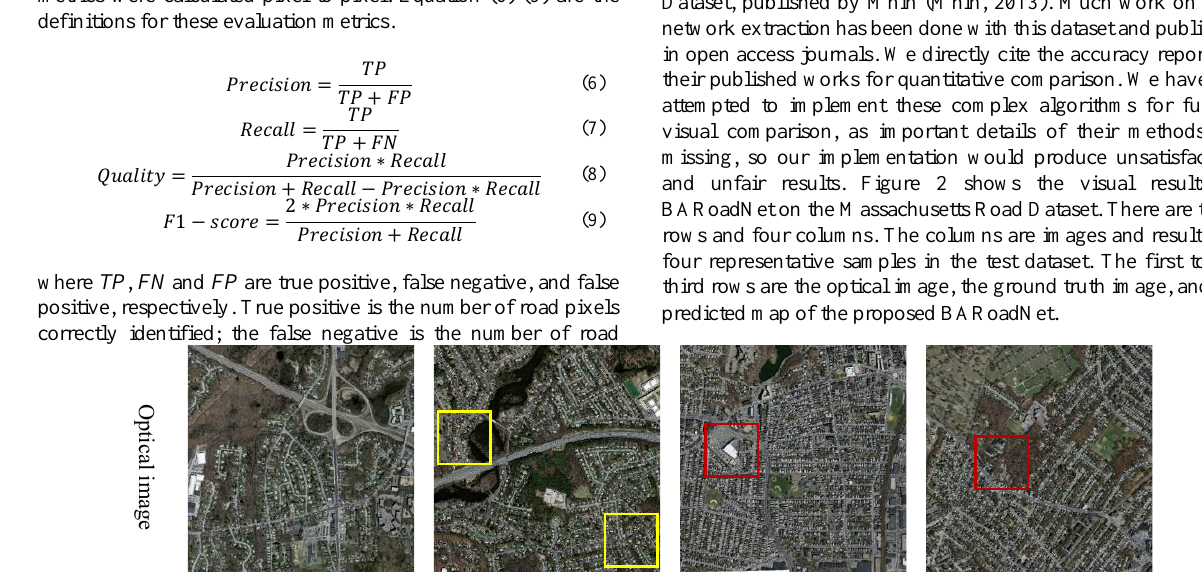
predicted map. Figure 2- (c) demonstrates that relax quality is the ratio of the overlap area to the union area of the buffered